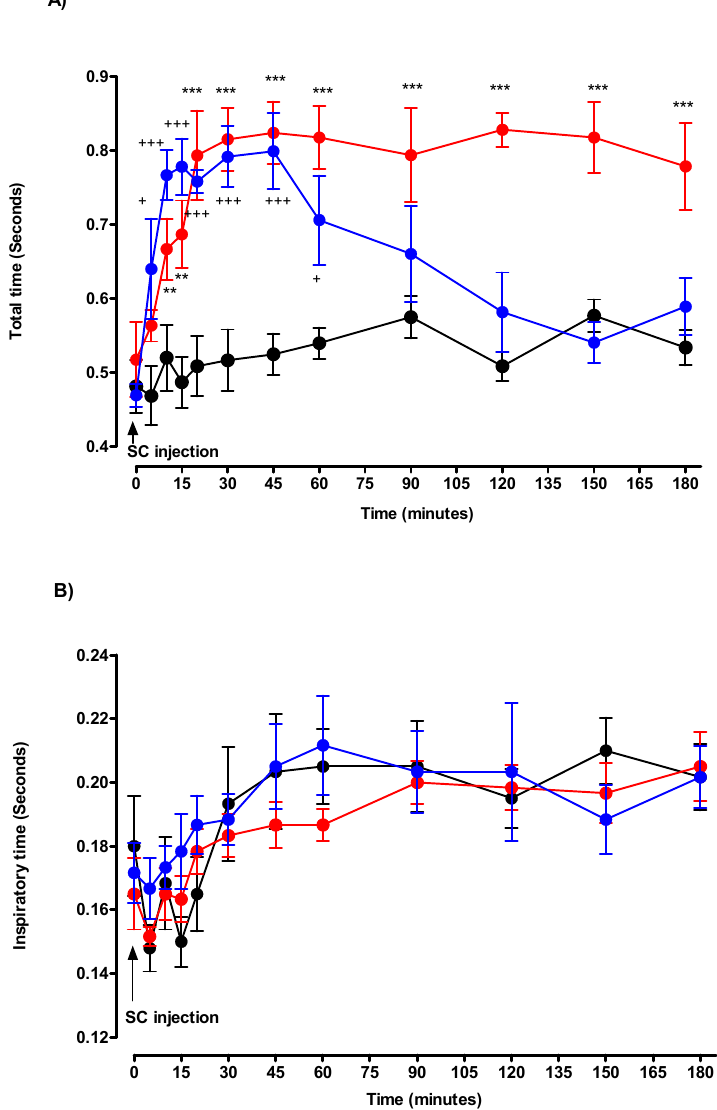
Figure 4. Effects of solvent (black circle), DMPO 50% MLD50 (blue circle), and DEPO 50% MLD50 (red circle) on ( A ) total time, and ( B ) inspiratory time. Arrow denotes the time of injection of solvent, DMPO, or DEPO. Each group consisted of six rats. Data are represented by mean ± SEM at each time after injection. DMPO vs. control: + p < 0.05, ++ p < 0.01, and +++ p < 0.001. DEPO vs. control: * p < 0.05, ** p < 0.01, and *** p < 0.001.